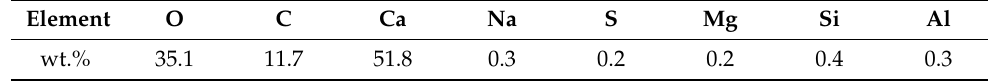
Table 3. CC of mussel shells.